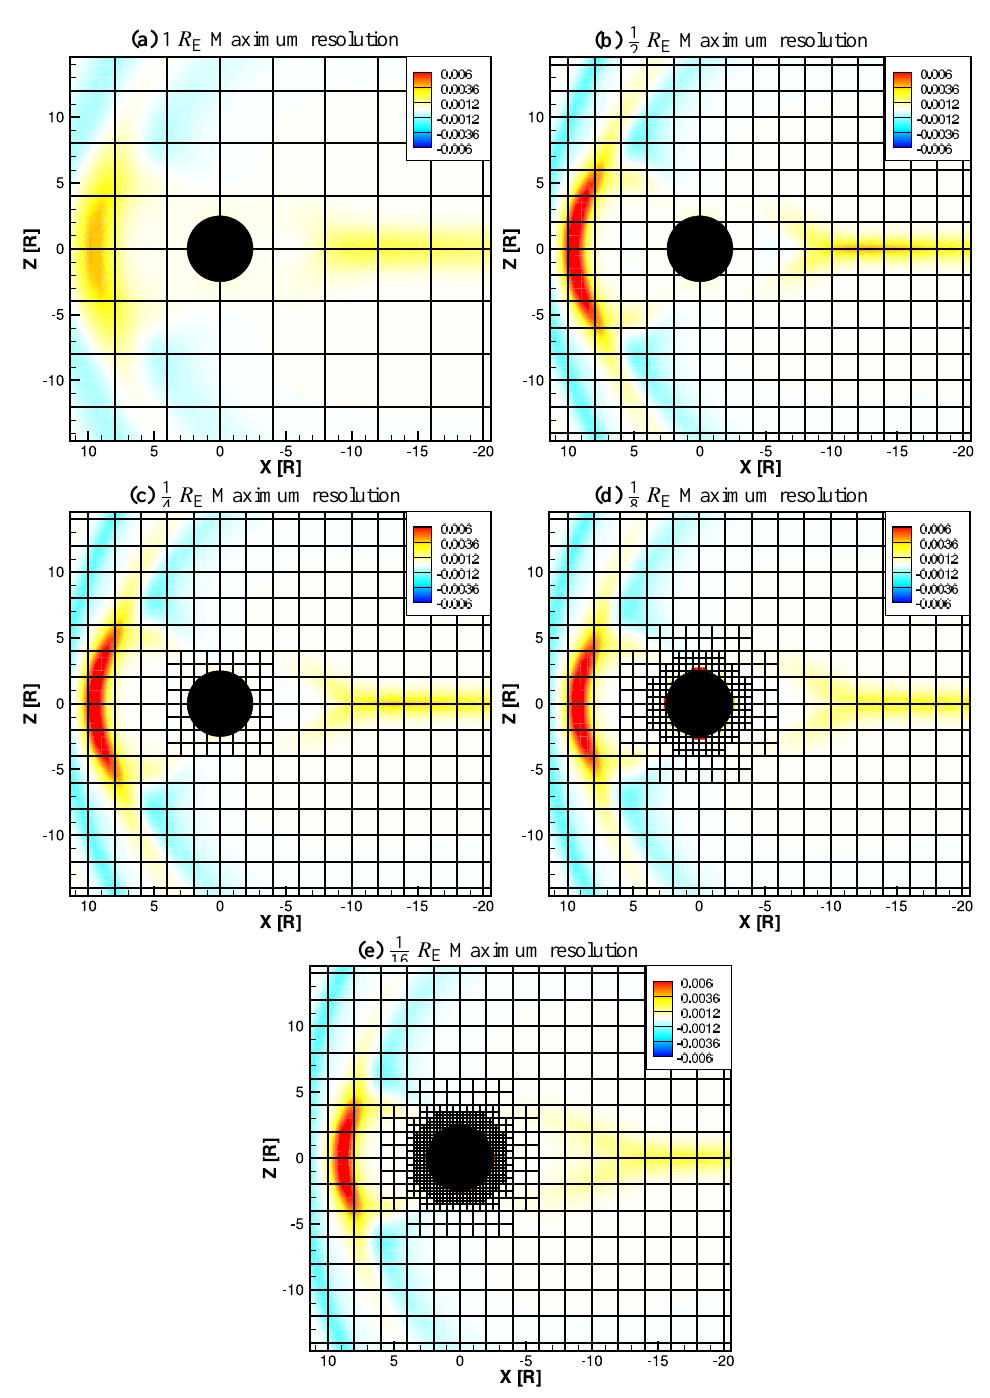
Fig. 1. Magnetospheric current density into and out of the plane (i.e. J y in µA/m 2 ) plotted as a contour with the grid structure overlayed for different iterations numbers through the simulation. The grid boxes indicate the block boundaries, which means that within each of the plotted squares, there are 4 × 4 cells. These plots show the different resolutions that are investigated in this study.